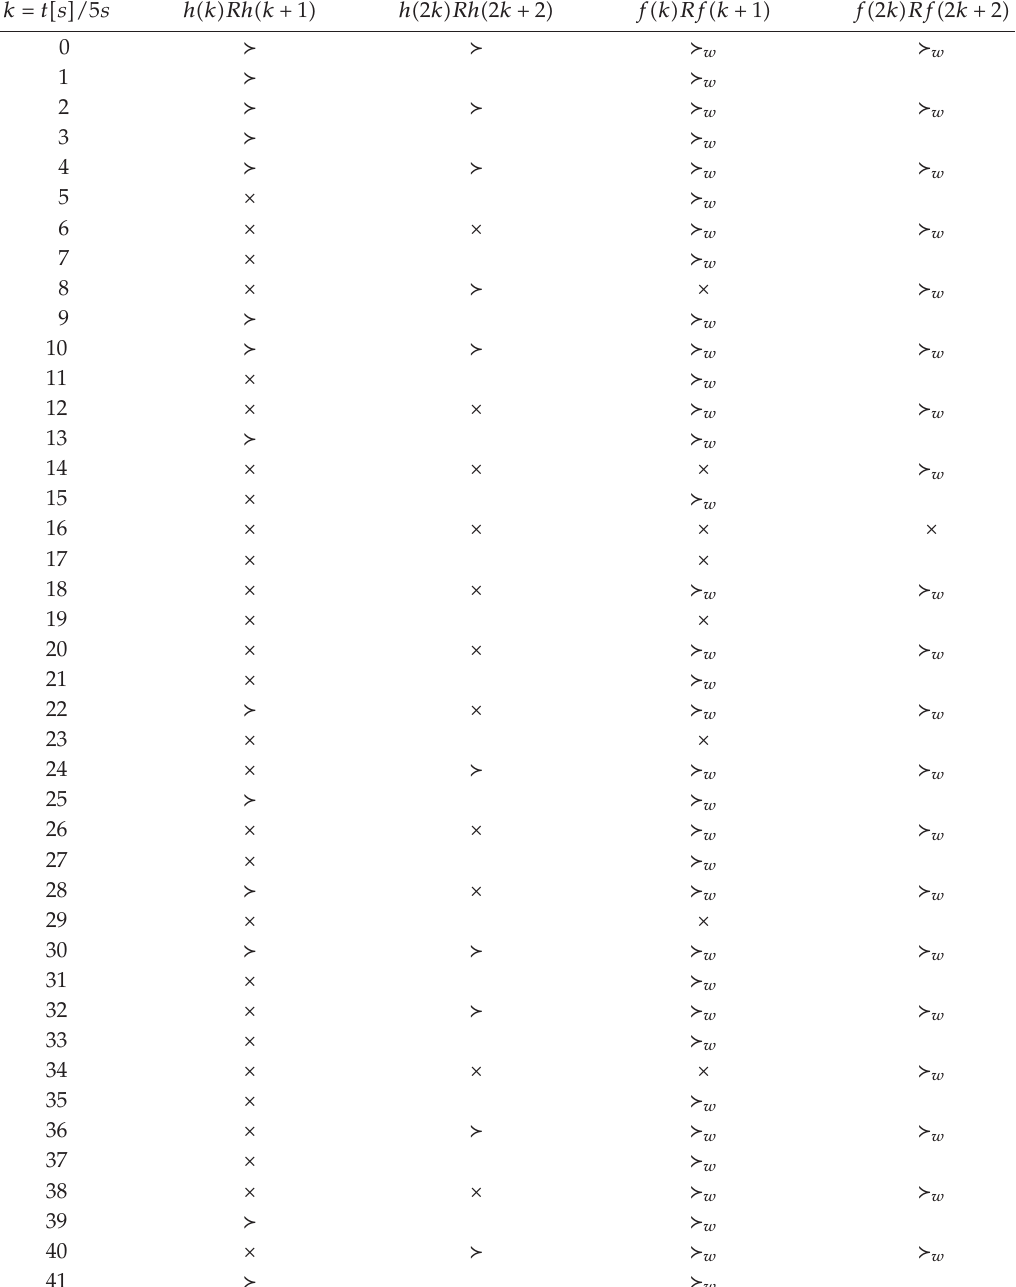
Table 2: The order of the di ff erent concepts of majorization concerning bubble-size distributions is given. One sees the time steps in the first column. The second and third columns show the relation R of classical majorization with di ff erent time steps. The transitions of the weak submajorization can be examined in the fourth and fifth columns di ff ering in the time steps. Incomparable distributions are denoted by ×